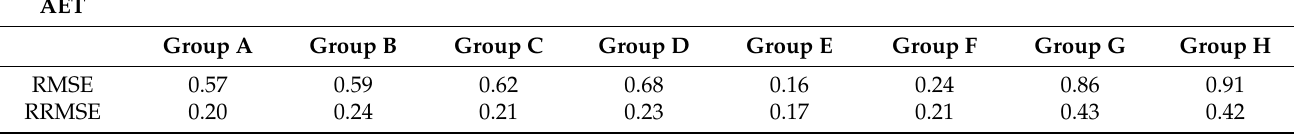
Table 7. Root Mean Square Error (RMSE) and Relative RMSE (RRMSE) calculated for each group of fields (as defined in Section 2.3.1) comparing the actual evapotranspiration (AET) calculated from airborne data (both images) and AET simulated by EnKF-SAFY_swb.